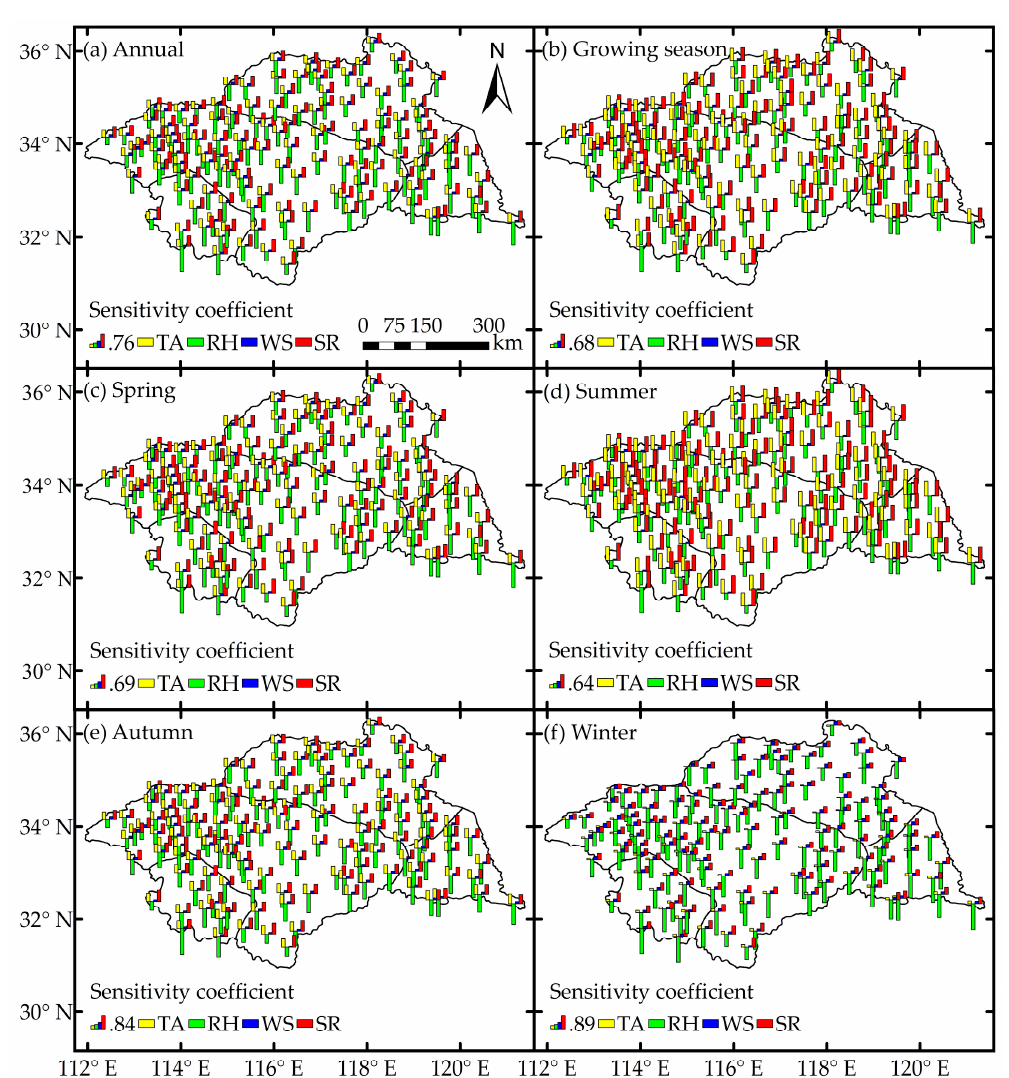
Figure 6. Spatial distribution maps of ( a ) annual; ( b ) growing season; ( c ) spring; ( d ) summer; ( e ) autumn; and ( f ) winter sensitivity coefficients during 1961–2014 in the HRB.